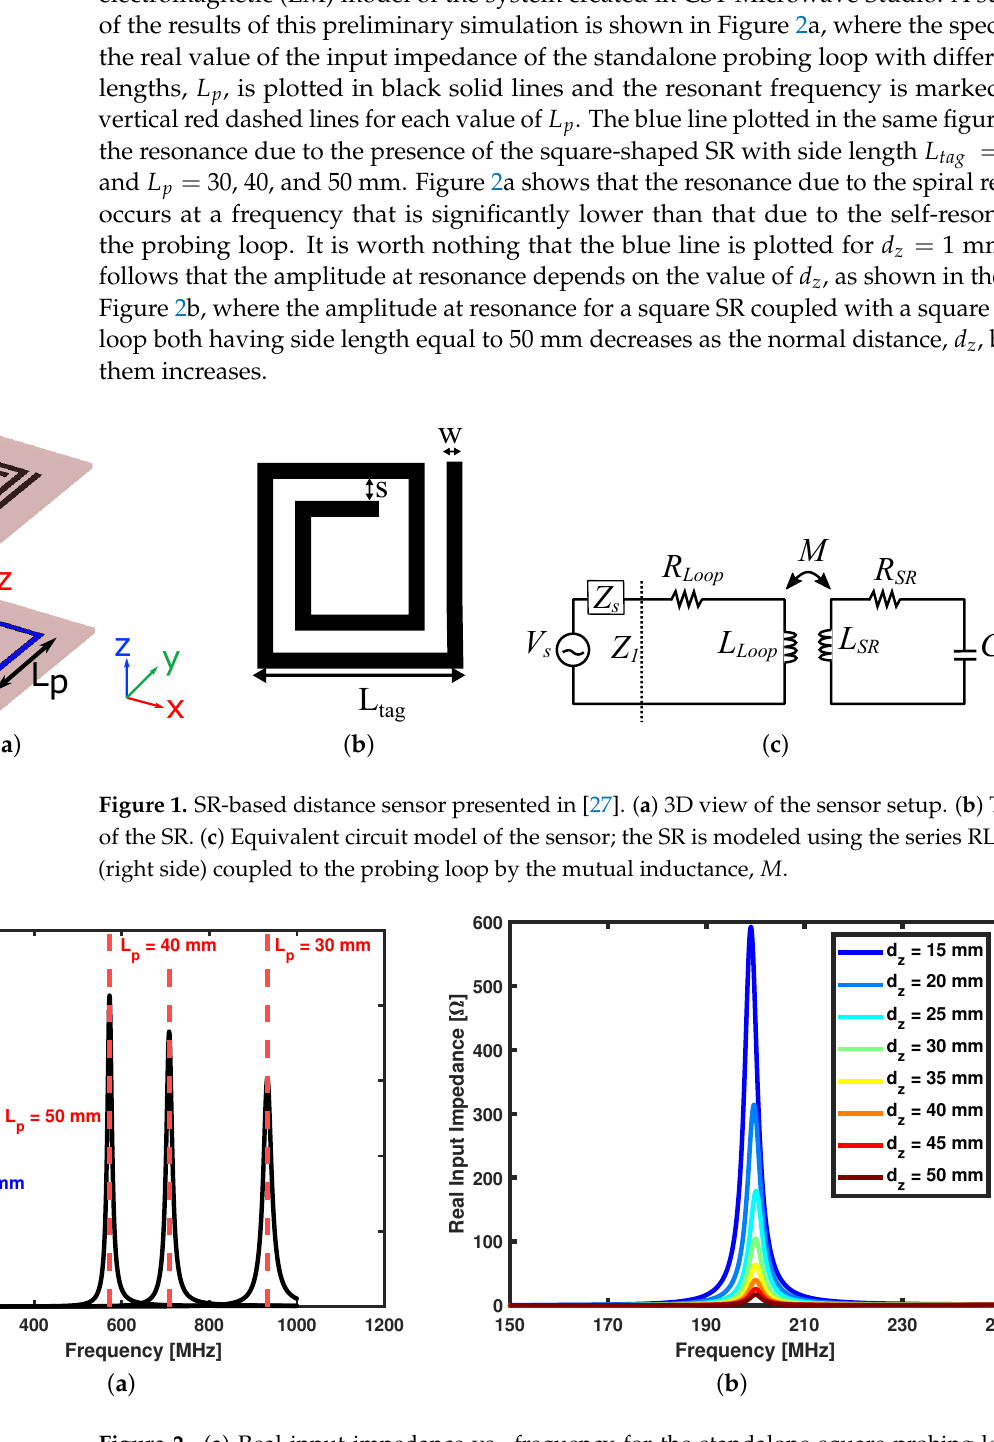
Figure 2. ( a ) Real input impedance vs. frequency for the standalone square probing loop with side length 30 mm, 40 mm, and 50 mm (black lines), and the case with an SR in close proximity having L tag = 50 mm shown for d z = 1 mm. ( b ) Real input impedance vs. frequency for sensor with w = s = 2 mm, N = 2 turns, and L p = L tag = 50 mm plotted at various values of d z , showing the dependence on the normal